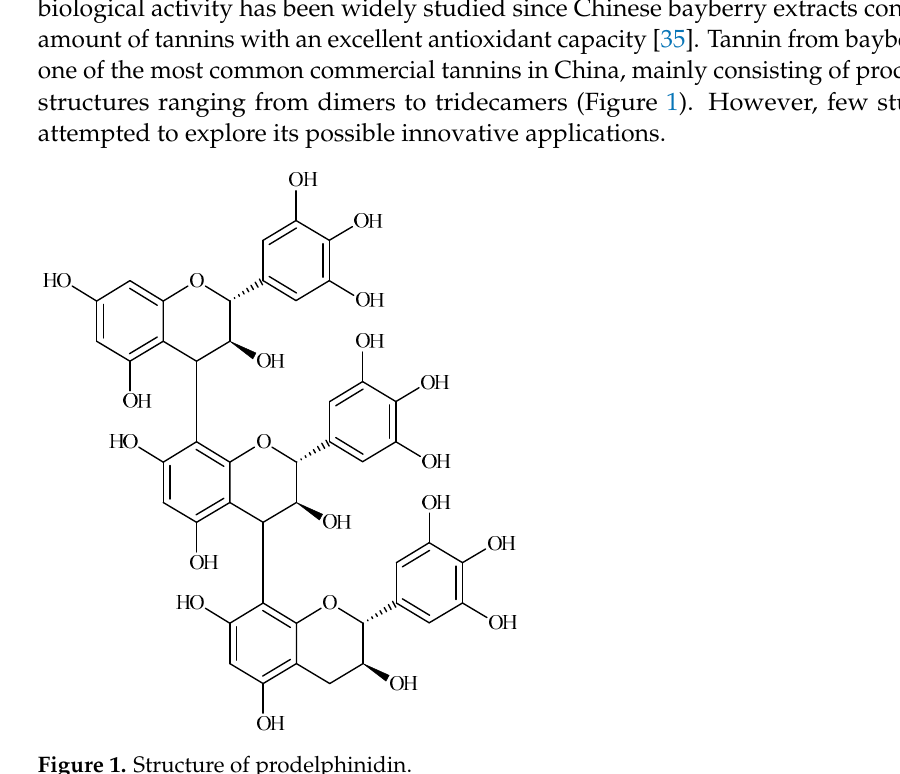
Figure 1. Structure of prodelphinidin .